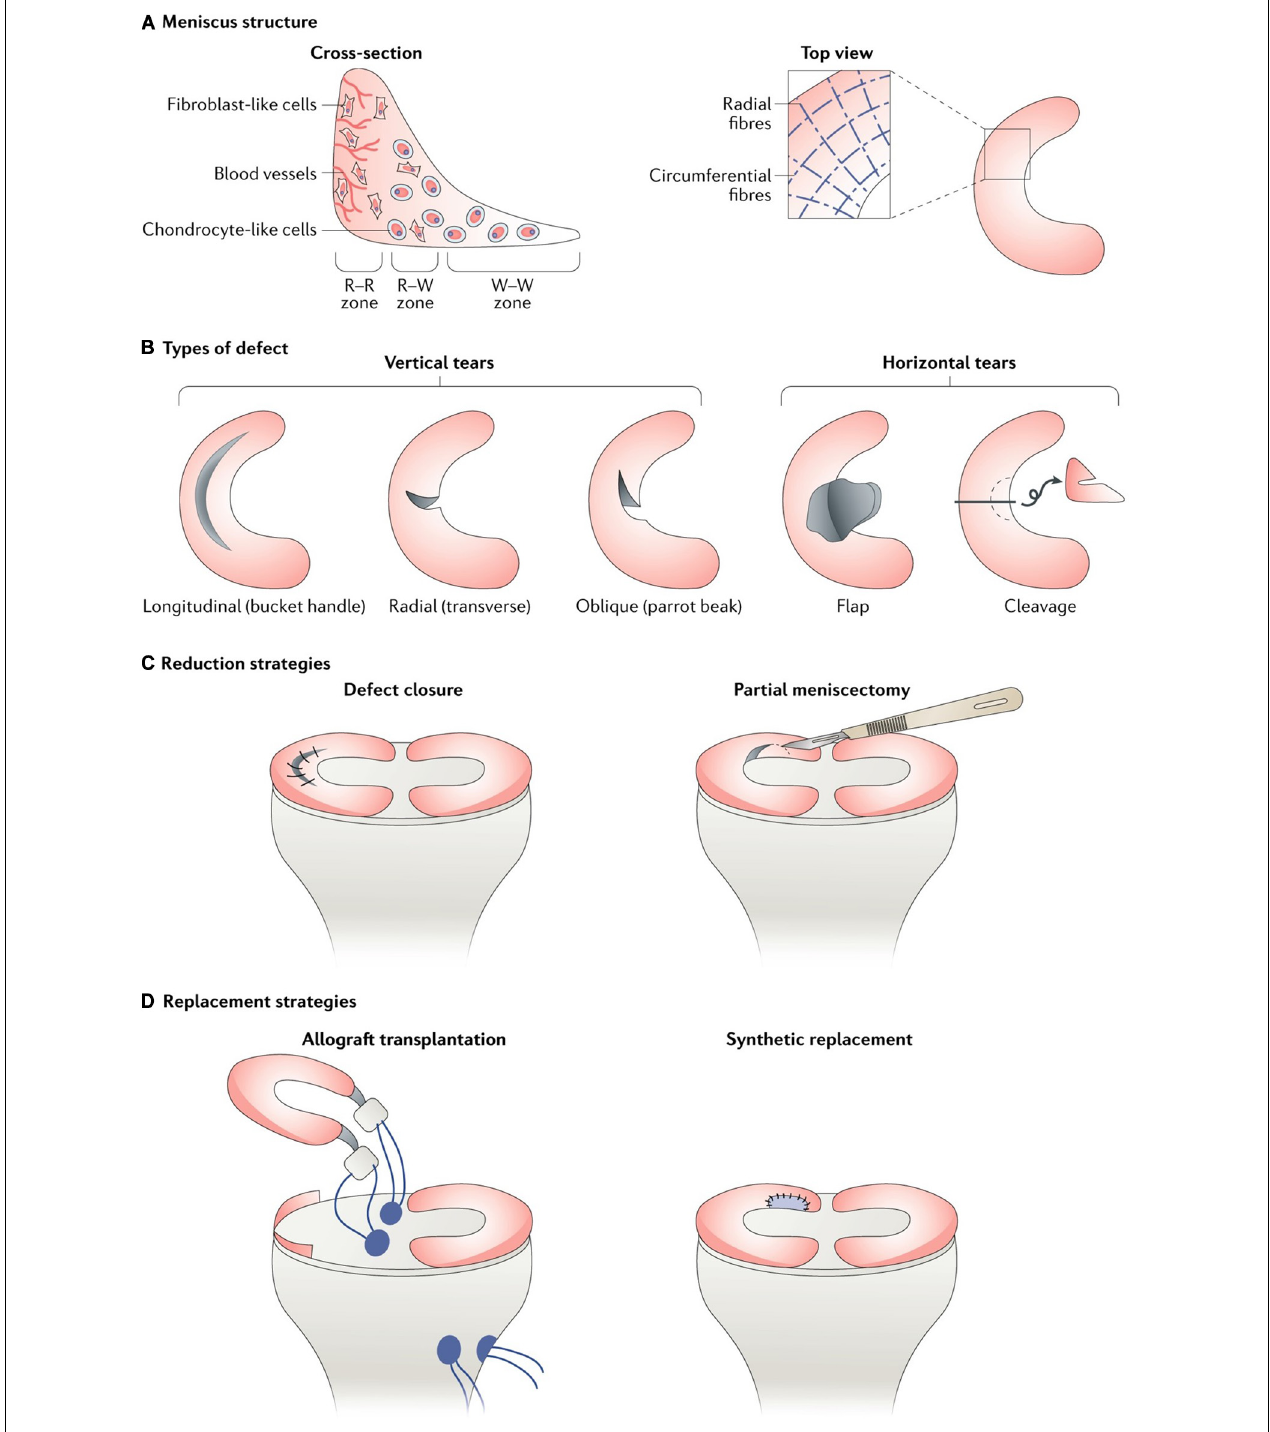
FIGURE 1 | (A) Meniscus consists of three main zones: red–red (R–R), red–white (R–W) and white–white (W–W). The R–R zone is fully vascularized and the W–W zone is avascular; (B) A variety of different types of defect can occur in the meniscus, some of which are easier to repair than others owing to their intrusion into vascular or avascular zones; (C) Reduction strategies in current use include defect closure with sutures or anchors and the trimming of torn pieces (partial or total meniscectomy); (D) Replacement strategies in current use include allograft transplantation and the use of synthetic implants. This figure was adapted permission from Kwon et al.